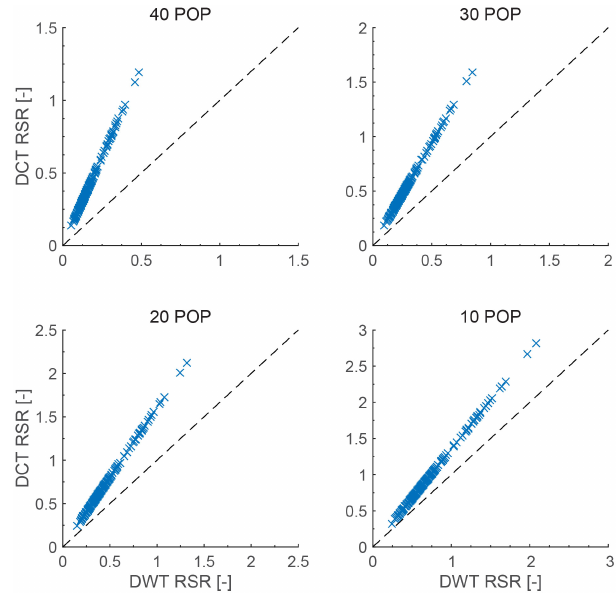
Figure 4. Comparative plots of RSR for the DCT and DWT using a different POP. Each data point represents a